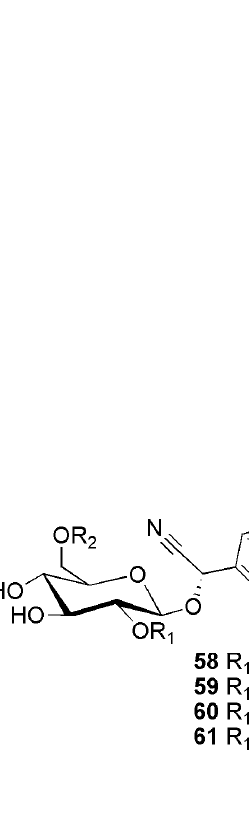
Figure 12. Cyanogenic glycosides group C-2, phenylalanine-derived cyanogenic glycosides featuring an unsubsti- tuted disaccharide in the sugar moiety: ( S )-epilucumin ( 58 ), ( S )-neoamygdalin ( 59 ), (7 S )-phenylcyanomethyl 1 (cid:48) - O - α - L -rhamnopyranosyl-(1 → 6)- β - D -glucopyranoside ( 60 ), (2 S) - β - D -apio- D -furanosyl-(1 → 2)- β - D -glucopyranosylmandelonitrile ( 61 ), oxyanthin ( 62 ), vicianin ( 63 ), lucumin ( 64 ), ( R )-amygdalin ( 65 ), (7 R )-phenylcyanomethyl 1 (cid:48) - O - α - L -rhamnopyranosyl- (1 → 6)- β - D -glucopyranoside ( 66 ), ( R )-eucalyptosin B ( 67 ), ( R )-eucalyptosin C ( 68 ), ( R )-eucalyptosin A ( 69 ).